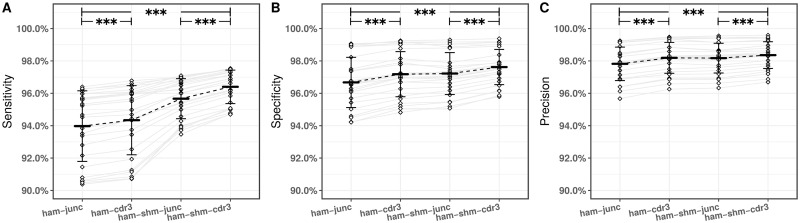
Integrating information from CDR3 similarity (recombination-based distance) and shared mutations in the V and J segments (SHM-based distance) improves clonal relationship inference.The spectral clustering-based framework was applied to identify clonally-related sequences in 25 simulated datasets (diamonds) generated via AbSim
R package [46] (Table 1). Performance was assessed by calculating (A) sensitivity, (B) specificity, and (C) precision via applying the recombination-based model on the junction (ham-junc) and CDR3 (ham-cdr3) regions, as well as the integrated model on the junction (ham-shm-junc) and CDR3 (ham-shm-cdr3) regions. Mean performance is indicated by the solid bars, while the error bars define one standard deviation. For the comparisons of interest the asterisks (***) indicate p < 0.001 by paired t-test.